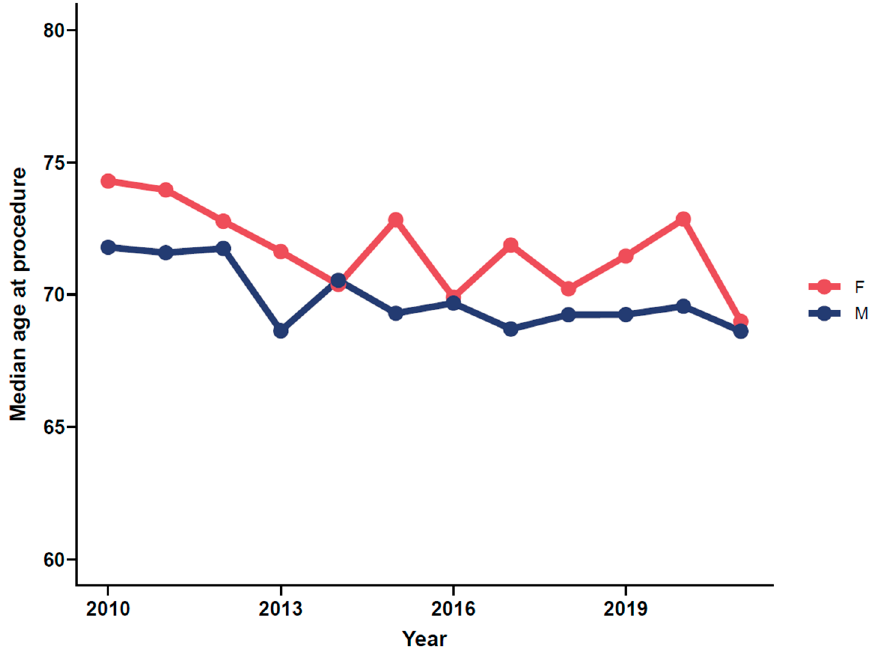
Figure 3. Median age of patients at first surgical and percutaneous treated PAD intervention (short- distance IC and CLTI combined), as separated by sex.